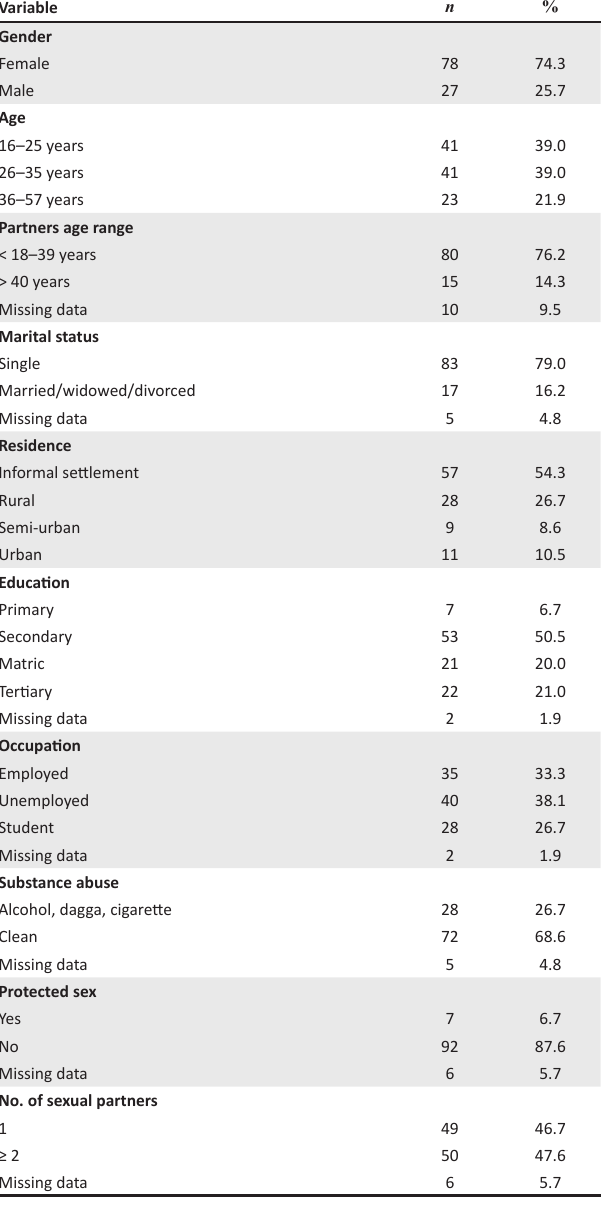
TABLE 2: Demographic characteristics of the study population .